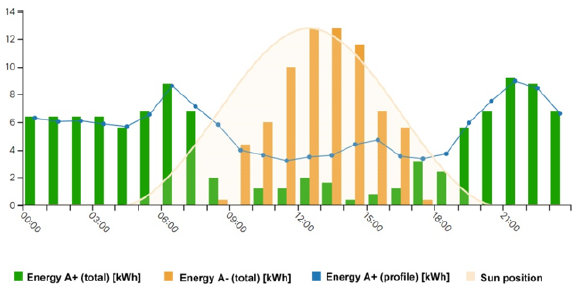
Figure 4: Graph of energy consumed (A+) and donated (A − ) in Sector 5 LSTP on an example weekday